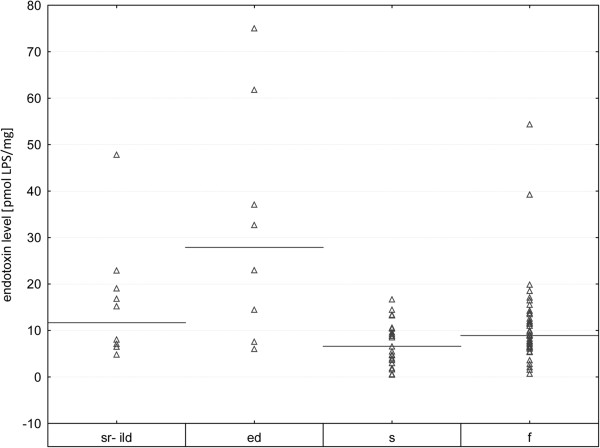
LPS in BALf supernatants. Data expressed as median values (lines); ed, eosinophilic disorders; f, fibrosis; s, sarcoidosis; sr-ILD, smoking related interstitial lung diseases.